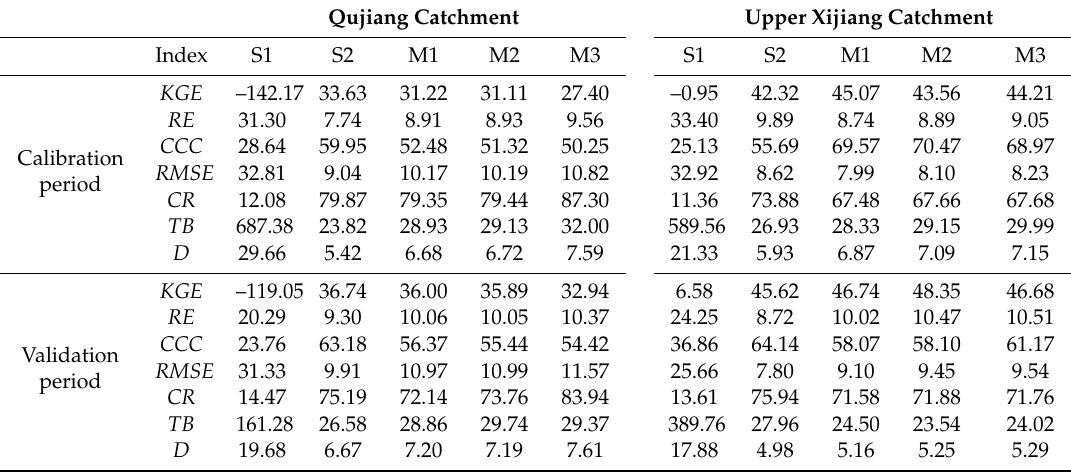
Table 5. Catchment-averaged indexes for the e ffi ciency analysis of model-simulated gridded SM that